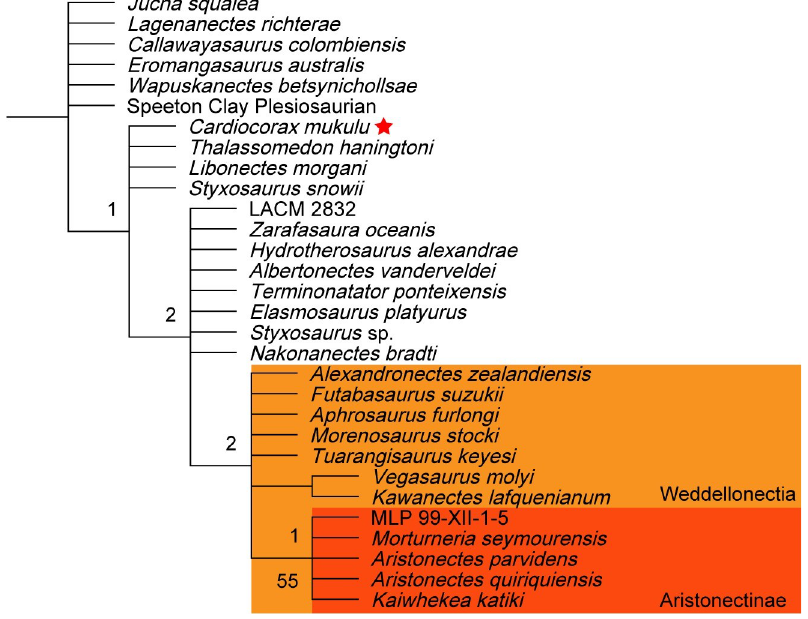
Fig 28. Analysis 1: Phylogenetic relationships of elasmosaurid plesiosaurians from heuristic search of plesiosauria. Bremer scores are displayed above the node. All bootstrap values above 50 are displayed below the node. RCI: 0.149, length: 1958) (Fig 29). The second implied weighting analysis (K = 12) returned Cardiocorax mukulu as an early-branching taxon and the sister taxon to Libonectes morgani (CI: 0.224, RI: 0.692, RCI: 0.155, length: 1909) (Fig 30).